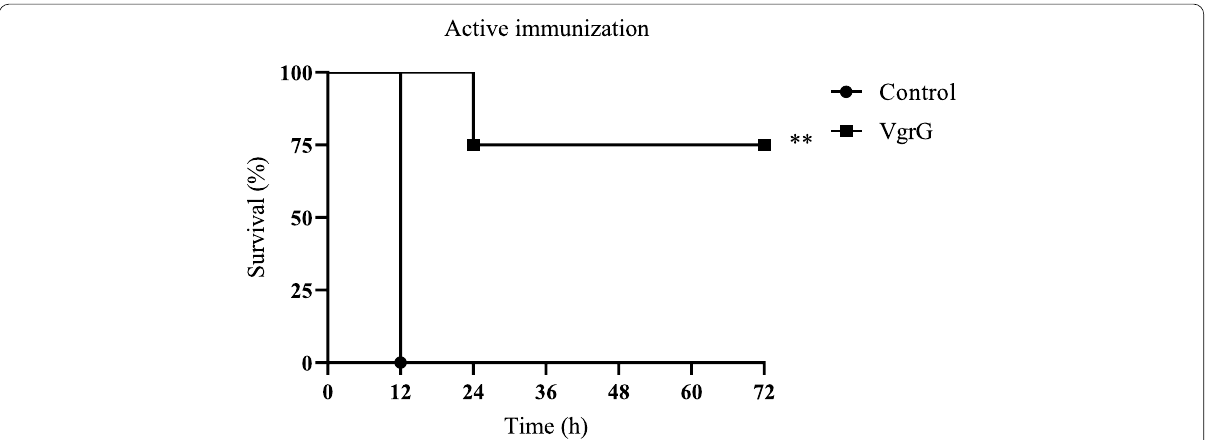
Fig. 2 The survival rate in actively immunized mice. The non-parametric log-rank test was used for the analyses of survival rates ( p <